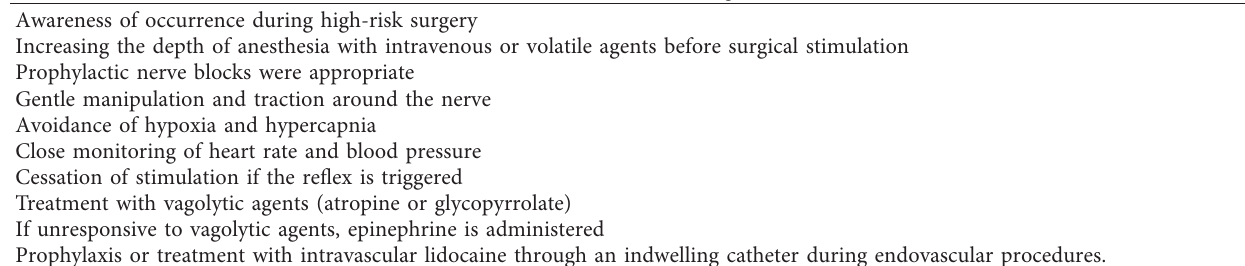
Figure 1: The trigeminocardiac reflex arc via branches of the trigeminal nerve in the cavernous sinus. TCR could also be initiated by stimulation of the dura mater supplied by branches of the trigeminal nerve. Table 1: Prevention and treatment of trigeminocardiac